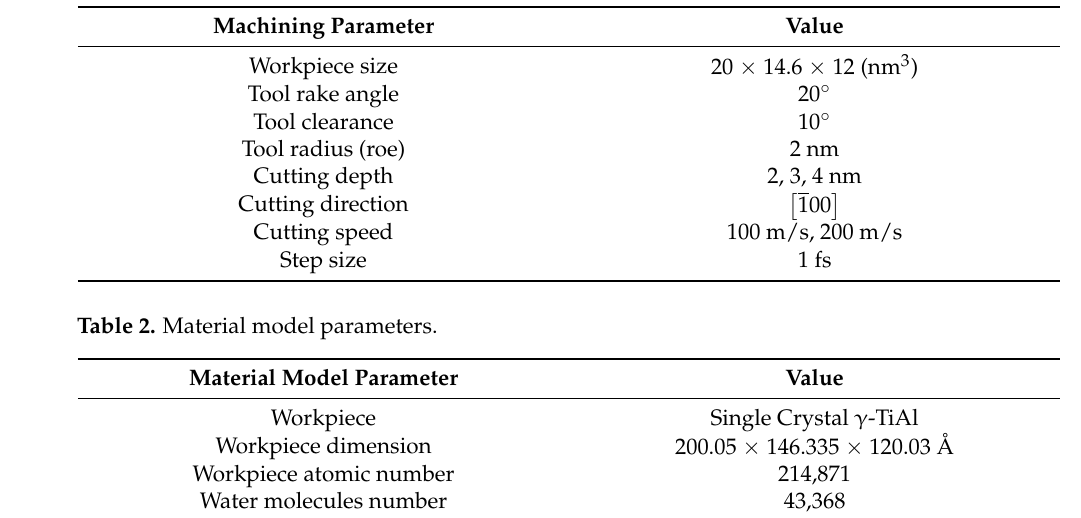
Table 1. Cutting parameters.